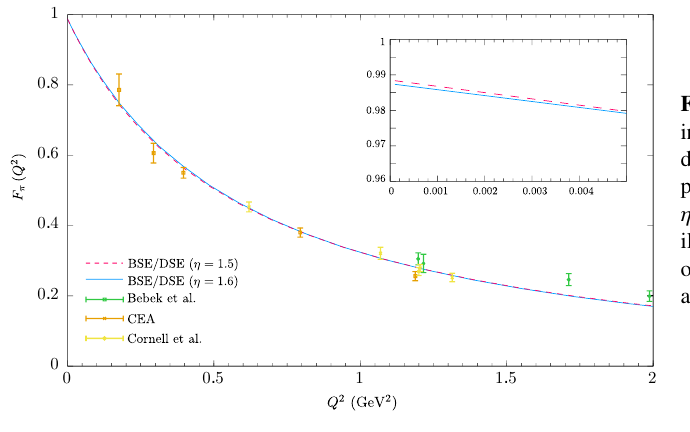
Figure 5. Pion form factor in the spacelike Q 2 > 0 domain for the model parameters η = 1 . 5 and η = 1 . 6. (The inset illustrates the impact of one of the technically motivated